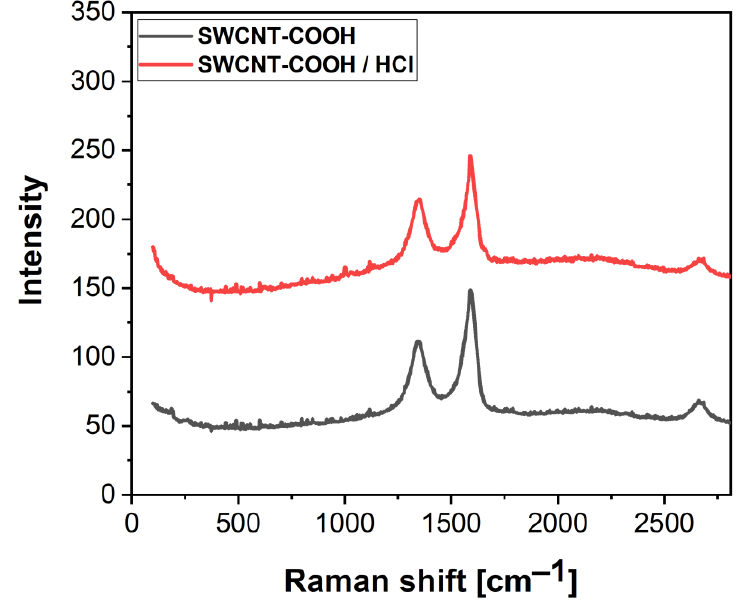
Figure 5. Raman spectra of SWCNT-COOH before and after the HCl treatment.